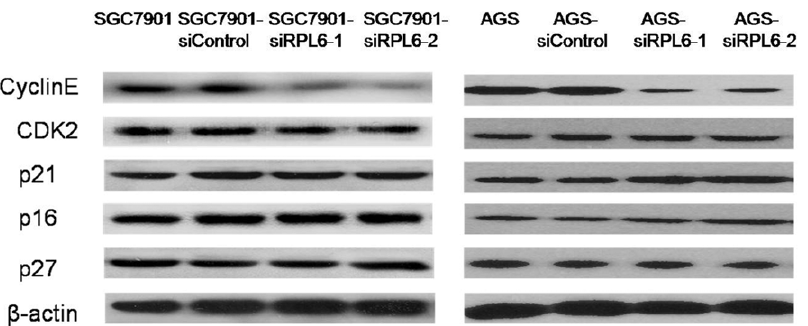
Figure 6. Detection of cell cycle-related proteins in SGC7901 cells. The expression of cyclin E, CDK2, p21, p16 and p27 in SGC7901 and AGS cell variants with down-regulated RPL6 was determined by Western blot using the corresponding antibodies. b -actin was detected as a loading control.